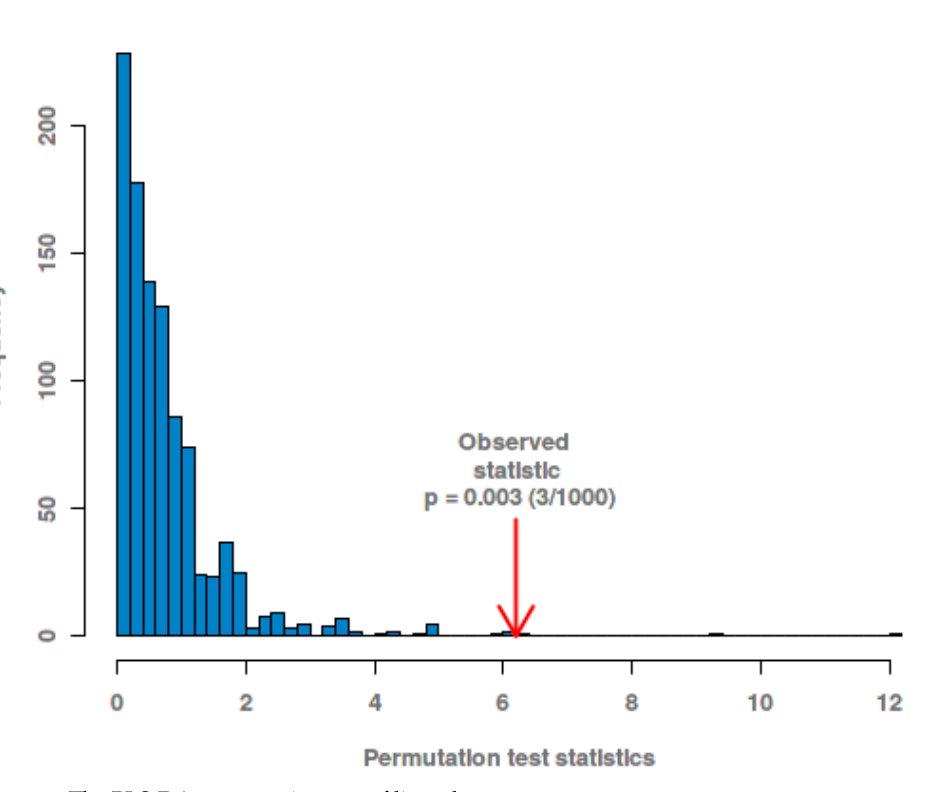
Figure 7. The PLS-DA permutation test of liver Figure 7. The PLS ‐ DA permutation test of liver data.